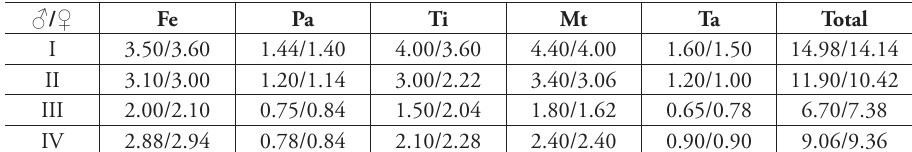
Table 1. Leg measurements of Metellina orientalis